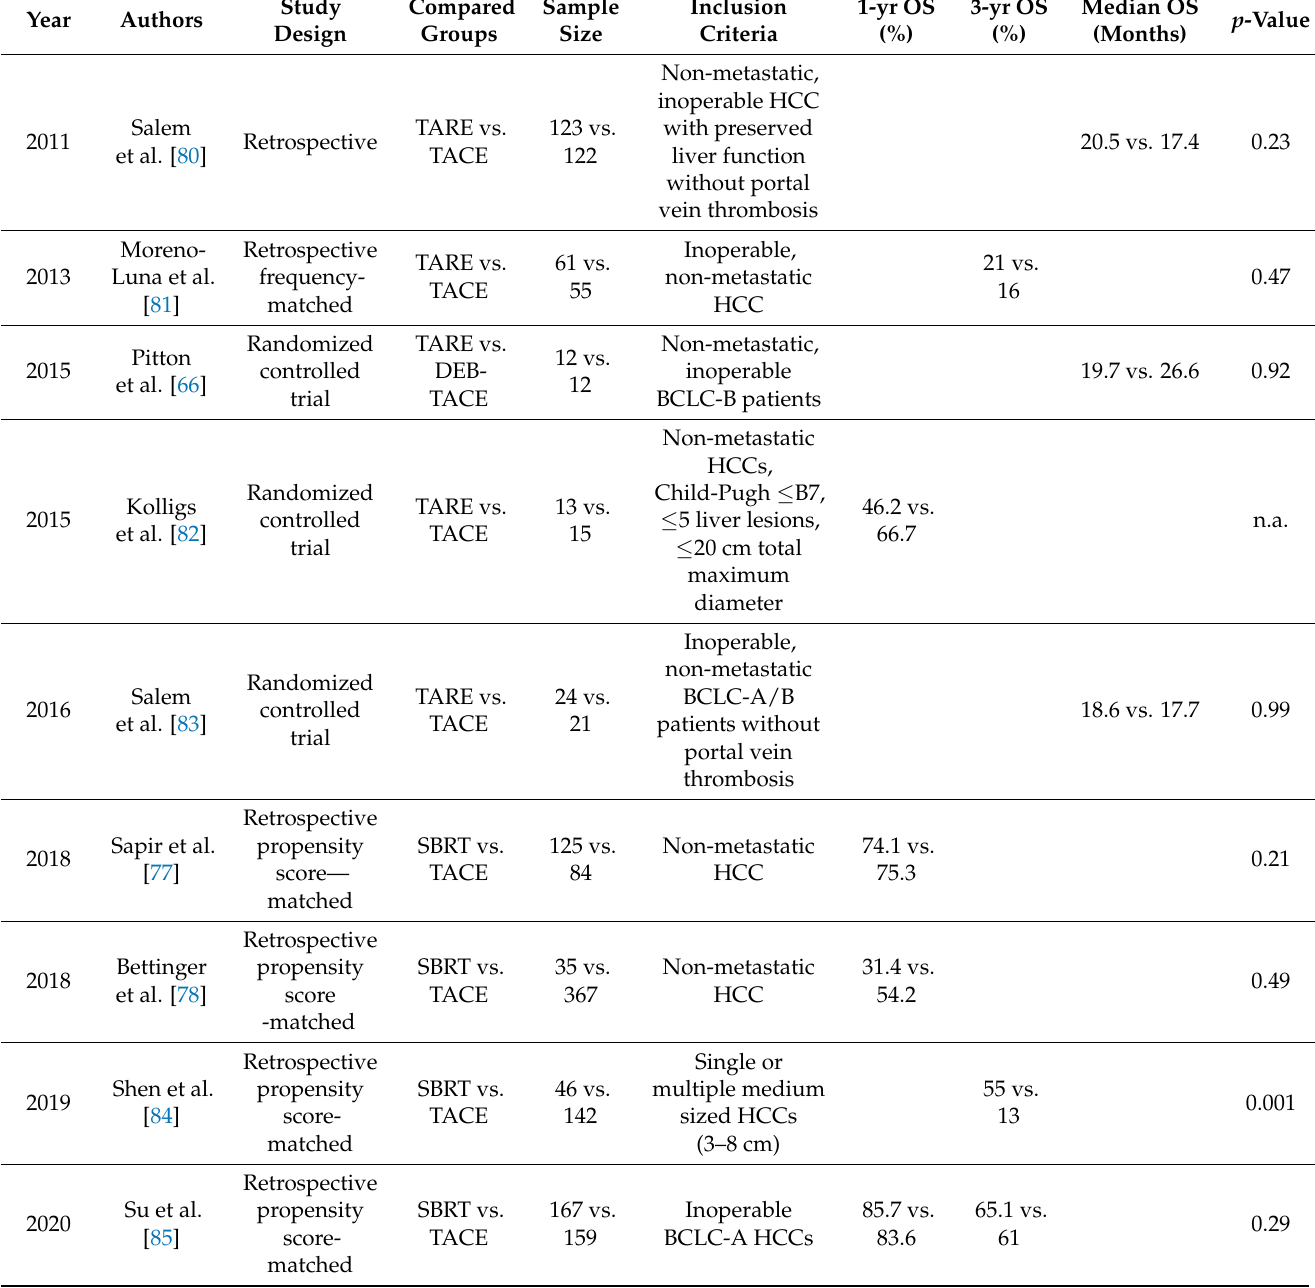
Table 2. Studies comparing SBRT or TARE vs. TACE in BCLC-B patients. OS: overall survival;